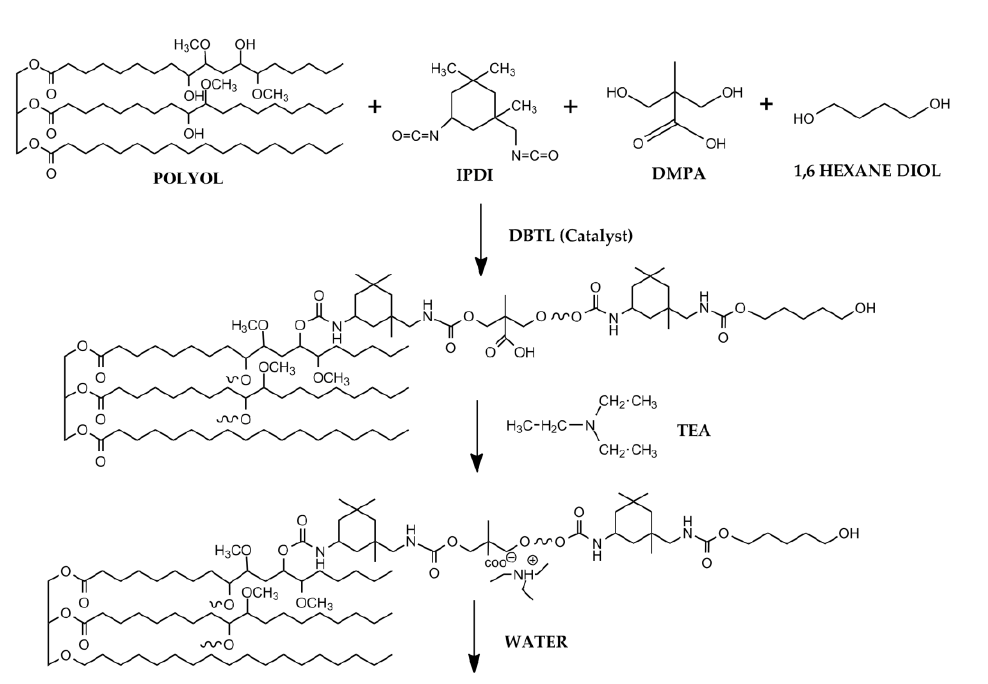
Figure 1. Reaction scheme of WBPU